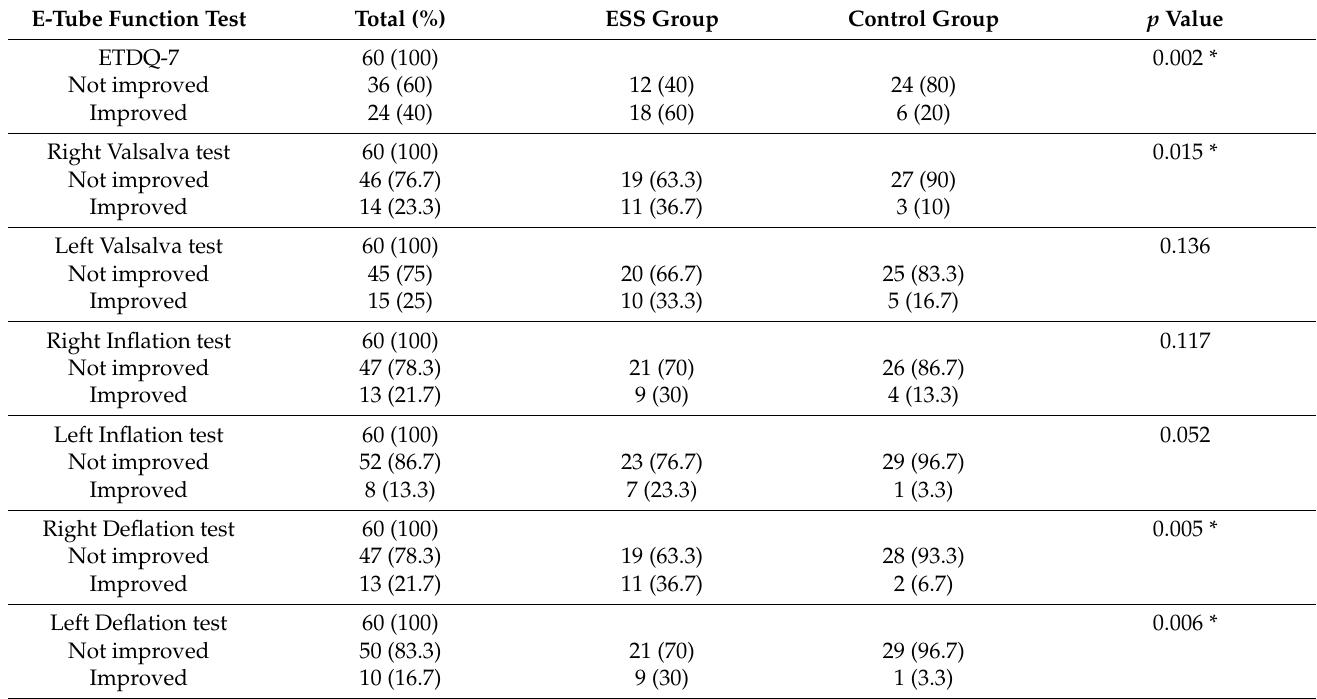
Table 3. Postoperative eustachian tube function test results of the